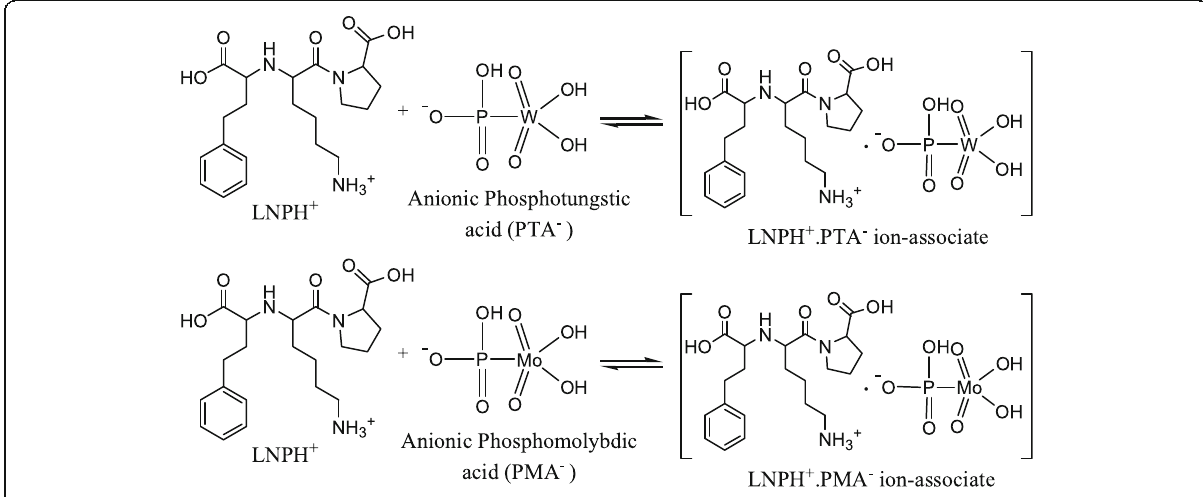
Scheme 1 Reaction pathway for the formation of ion-pair complex between LNP and